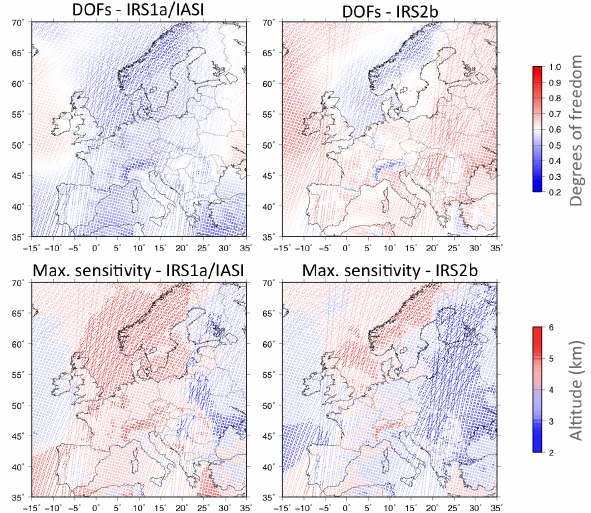
Figure 14. DOFs (top) and altitude of the maximum sensitivity (bottom, in kilometres) associated with the 0–6km ozone retrieved on 20 August 2009, for IRS1a/IASI (left) and for the IRS2b scenario (right). This simulation was performed using a regional model that described an increase of ozone observed in Europe at that time. See Sellitto et al. (2013) for a full description of this case.